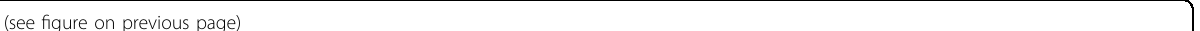
Fig. 5 Inhibiting LHb eCB hydrolysis or activating LHb CB1Rs decreases alcohol-seeking in rats with a history of chronic intermittent exposure to ethanol vapor (CIE). Panel ( a ) depicts the experimental timeline. Adult male Long-Evans rats were fi rst trained to drink alcohol for 4 weeks in the intermittent access 2-bottle free-choice (IA2BC) paradigm, followed by training for ethanol self-administration (SA) in the operant chambers in the FR1 paradigm for 8 – 10 weeks. They then were exposed to either CIE or Air vapor for 8 weeks. The number of active lever presses ( b ) and ethanol consumption ( c ) of CIE exposed rats signi fi cantly increased compared to before CIE or Air control rats. At 24-h abstinence from the last drinking session, a selective FAAH inhibitor (URB597), MAGL inhibitor (JZL184), CB1R agonist WIN55,212-2 (WIN), or Vehicle was bilaterally injected into the LHb 30 min before a drinking session. Panel ( d – l ) summarizes the effect of these compounds on active lever presses in both Air ( d , g , and j ) and CIE rats ( e , h , and k ), as well as the change of ethanol consumption ( f , l ). All data are expressed as mean ± SEM. ^^^ p < 0.001 vs baseline (BL) within CIE or Air group revealed by one-way RM ANOVA, *** p < 0.001 vs Vehicle or URB597/JZL184/WIN + RIM within CIE group revealed by two-way ANOVA; # p < 0.05 vs Vehicle or URB597/JZL184/WIN + RIM within CIE group, by one-way ANOVA followed by Bonferroni post-hoc test. n = 16-18